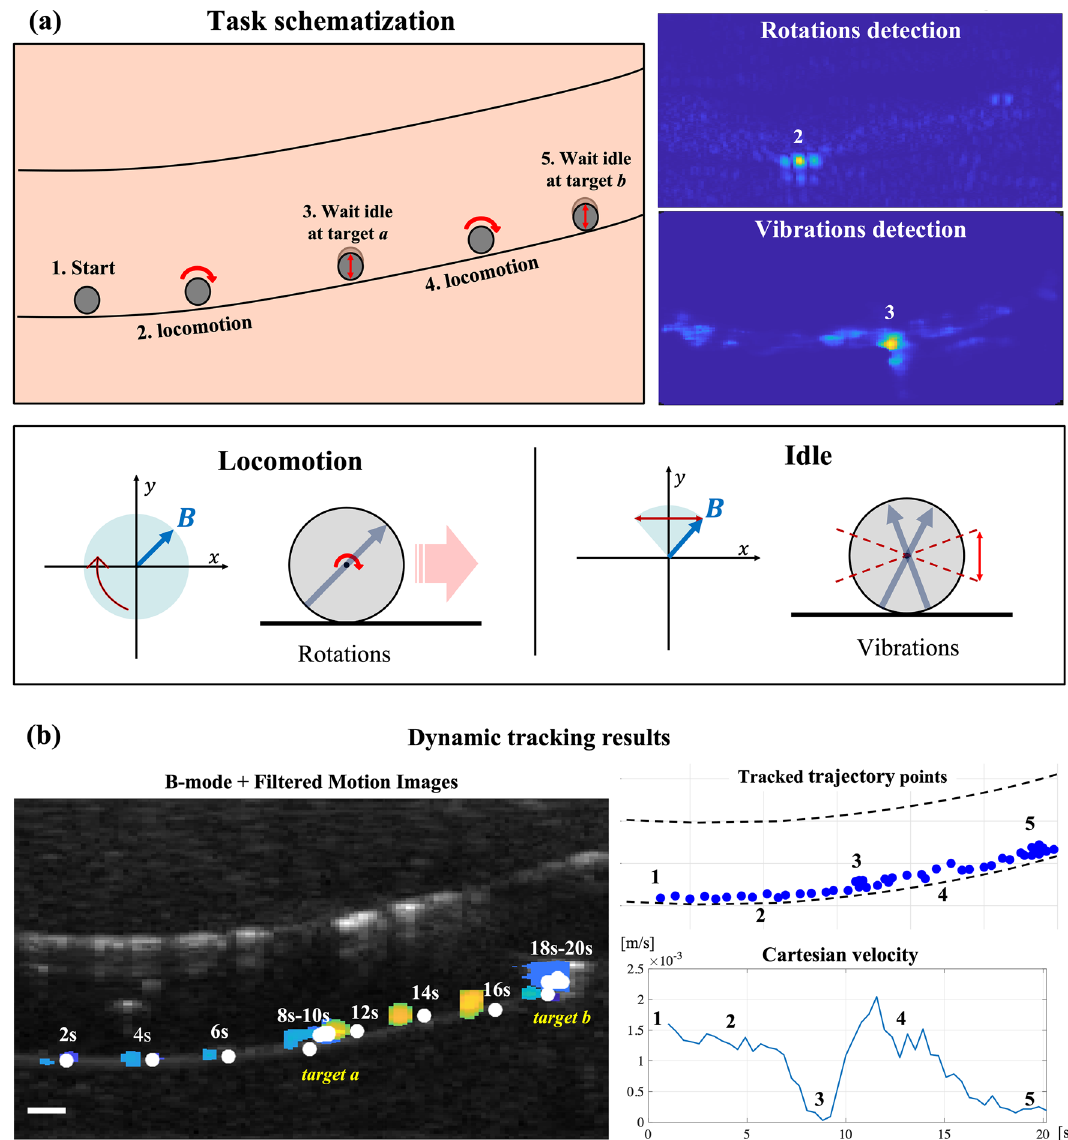
Figure 6. Phase-based tracking in a multi-modal navigation task. ( a ) In the defined navigation task, the MR can assume two different states: rolling and idle. A rotating magnetic field activates rolling locomotion state while, in the idle state, micro-vibrations are induced by harmonic oscillations of the magnetic field. Two different phase analysis strategies are performed according to the MR status, namely rotations detection and vibrations detection. ( b ) Results of the multi-modal navigation tracking experiments. The dual tracking approach allowed for robust continuous tracking of the MR during the entire task. The estimated cartesian velocity faithfully reports the expected MR behavior during the different navigation task phases (1–5). The scale bar is 1